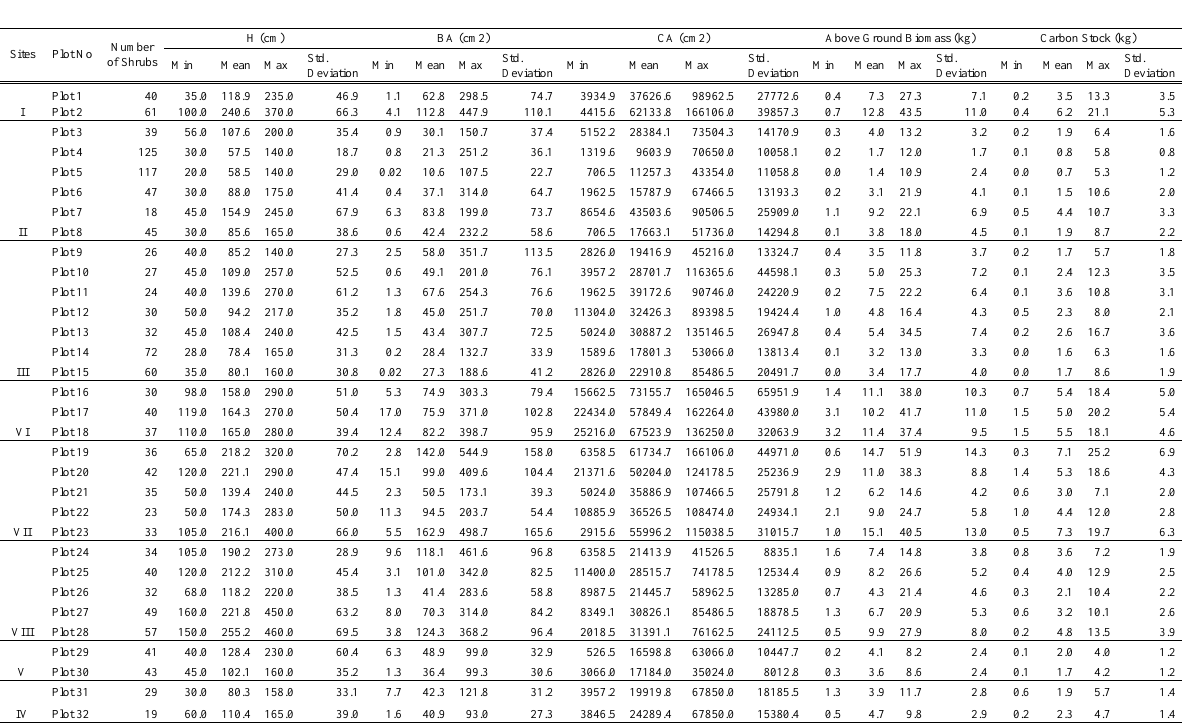
Table 3. Statistical summary of measured and calculated features as the growth Height (H), Basal area (BA), Canopy area (CA), Biomass (AGB)and Carbon stock (C) of above-ground for Haloxylon. The CA and BA were derived from canopy diameter in two perpendicular directions and diameter at breast height or basal circumference, respectively. The biomass was estimated using an allometric equation for Haloxylon species from Buras et al., (2012). Carbon contents for above-ground biomass are